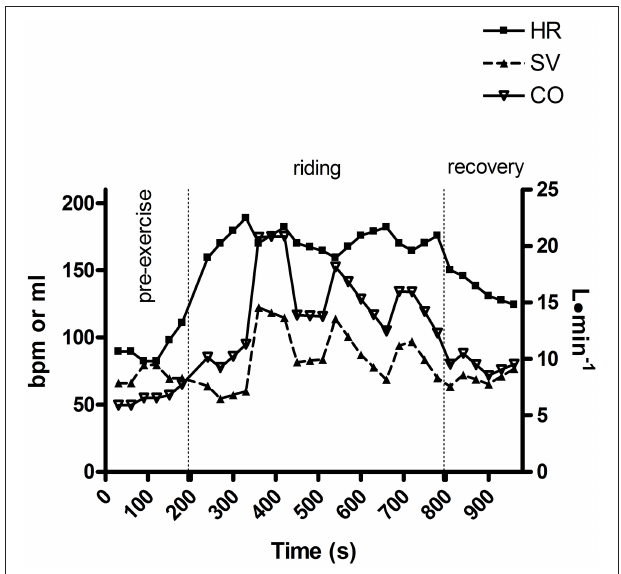
FIGURE 2 | An example of heart rate (HR), stroke volume (SV), and cardiac output time course throughout an Enduro session in one subject.